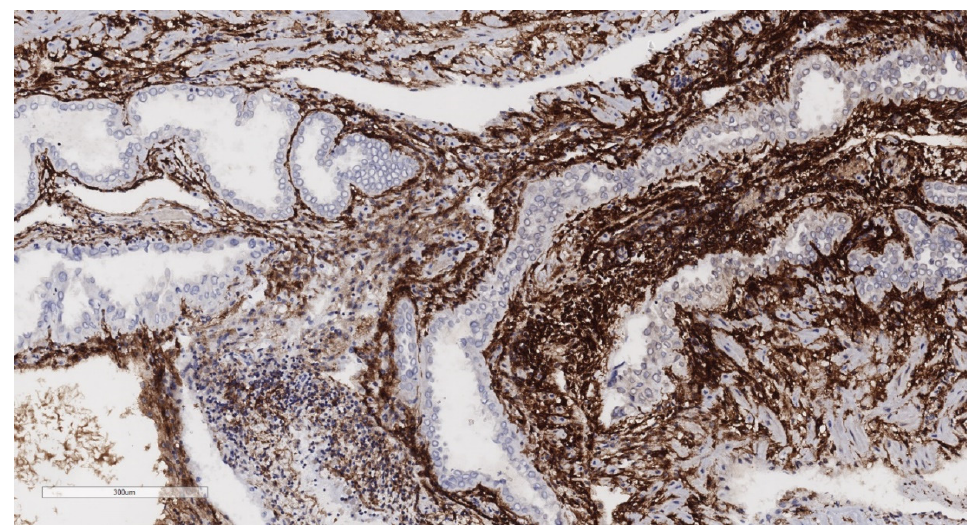
Figure 6. CD10, 10×. Immunohistochemistry for CD10 highlights the endometrial stroma. Table 1. Baseline characteristics of the study population stratified by presence or absence of adenomyosis.